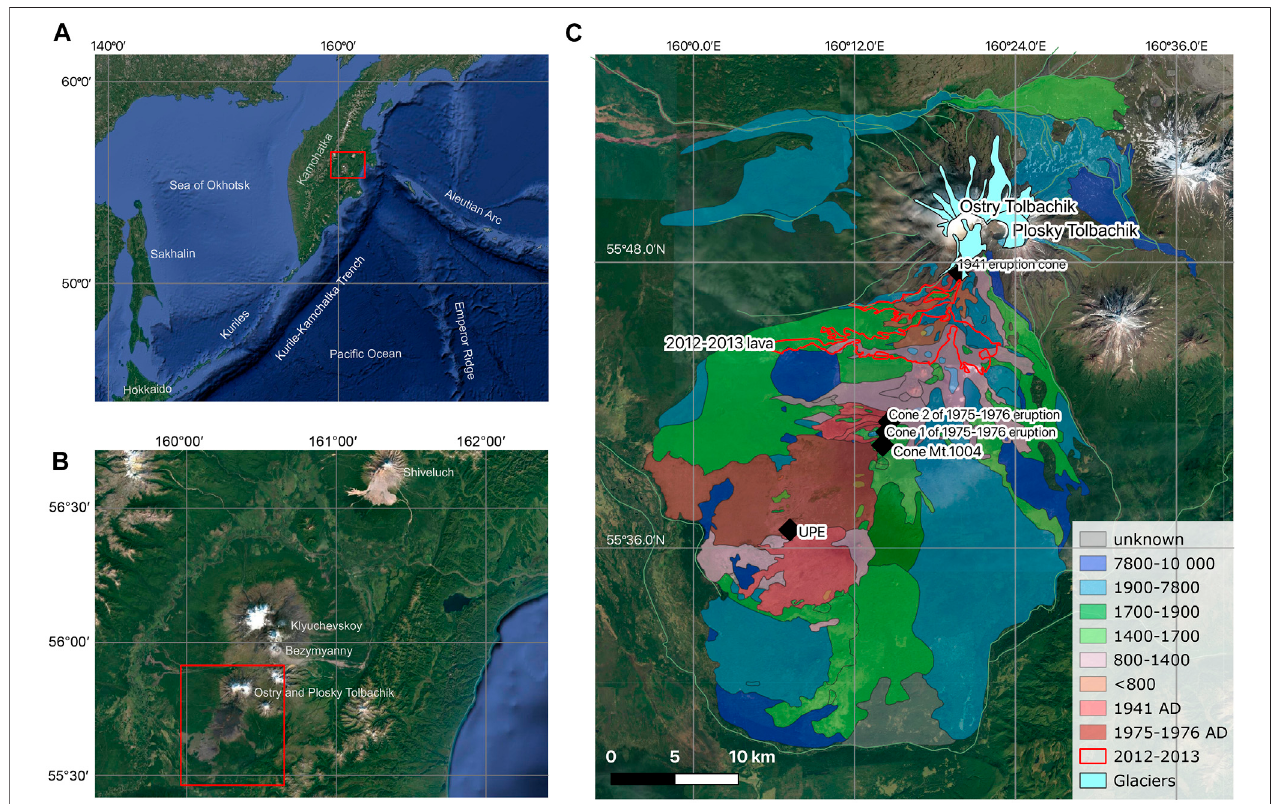
FIGURE1| MapsofKamchatkaandadjacentareas (A) ,Klyuchevkoygroup (B) andtheTolbachikmonogeniclava fi eldshowingindividualventsandlava fl ows (C) . The map was compiled by Braitseva et al. (1984) based on tephrochronological dating of lava fl ows and regional marker tephra layers, and improved by Churikova et al. (2015a). Satellite images are from google.com/maps.